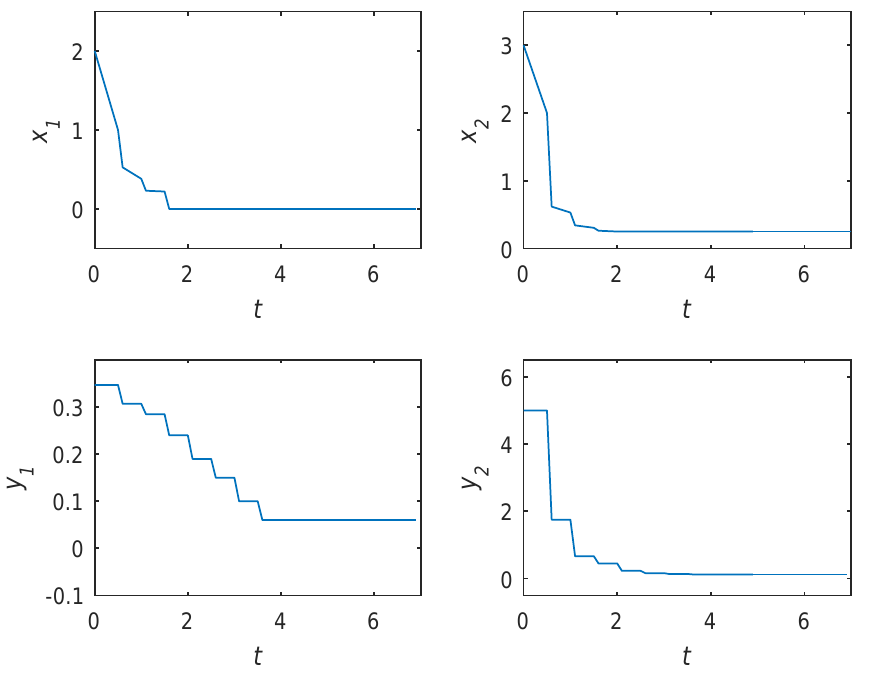
Figure 1. The global exponentially stable behavior of model (6), (7) with respect to the function (cid:113) + x 2 + y 2 + y 2 h = x 2 . Behavior of the state variables x 1 ( t ) , x 2 ( t ) , y 1 ( t ) and y 2 ( t ) . 2 2 1 1